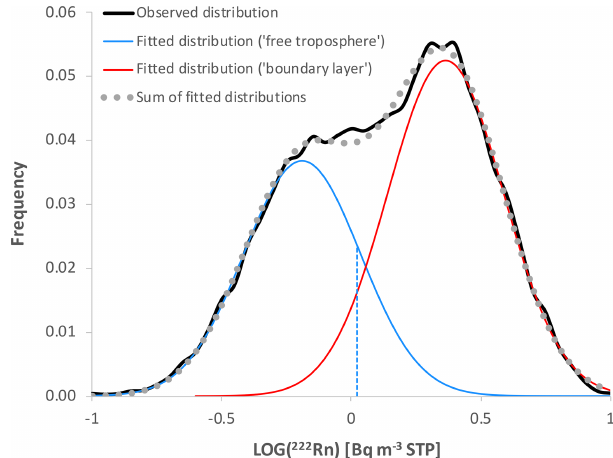
Figure 1. Probability density function of the log-transformed hourly mean radon concentration observed during the years from 2016 to 2020 at Jungfraujoch (black line). The sum of two fitted and weighed log-normal distributions (grey dotted line) closely matches the observed distribution. The fitted distributions most likely repre- sent the distribution of free tropospheric air masses (blue continuous line) and that of air masses influenced by the planetary boundary layer (red line). Ninety percent of the values below the dashed ver- tical line belong to the fitted “free troposphere” distribution (figure adapted from Conen et al.,